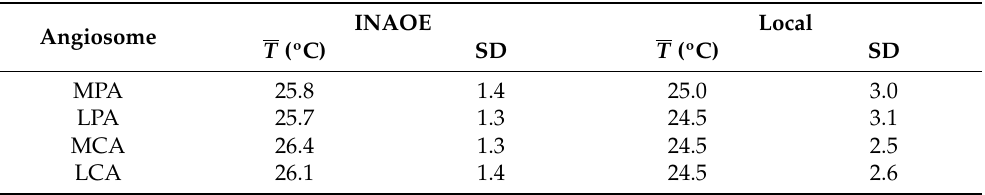
Table 1. Mean temperature values per angiosome in the control group for the INAOE database [47] and the local dataset described in Section 2.2. SD indicates standard